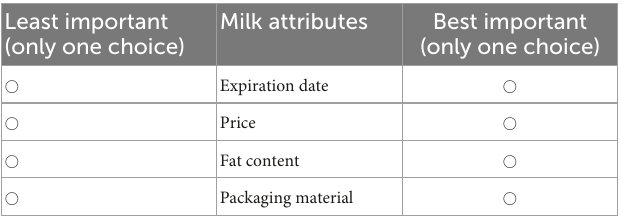
TABLE 1 Example of a best-worst scaling question (choice set). Least important (only one choice)